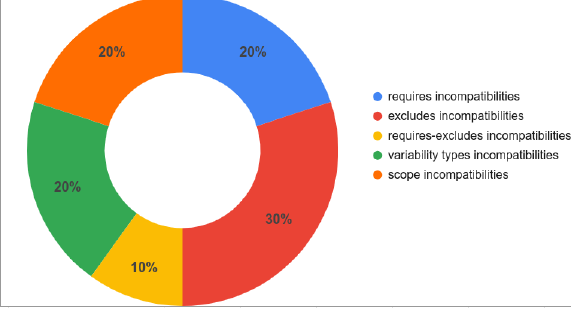
Figure 17. Expected Results—Percentage of incompatibilities for each